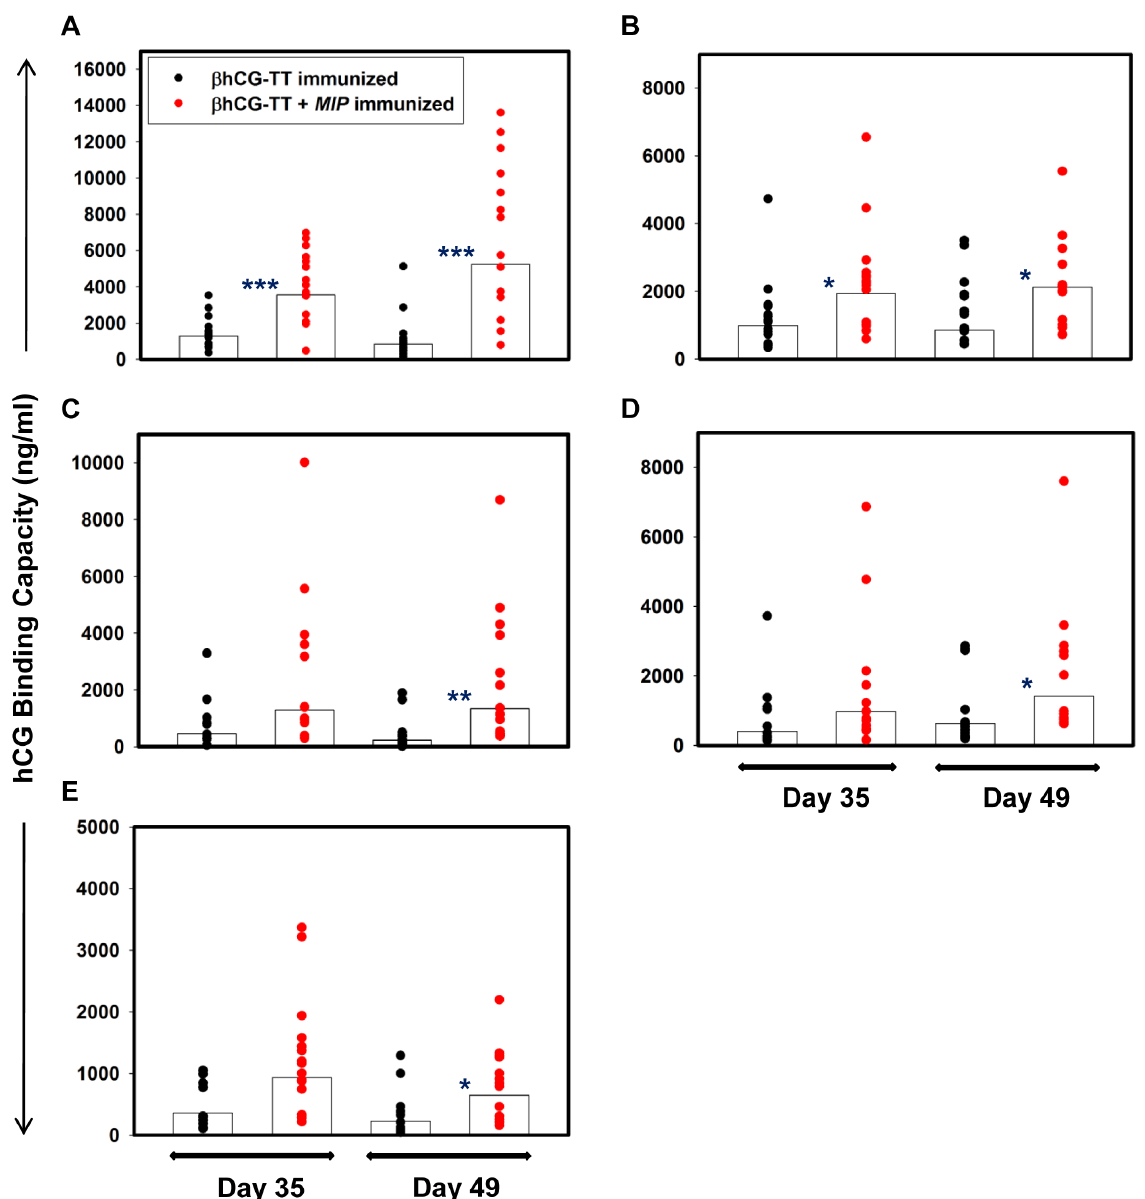
Figure 5. Immunogenecity studies. Immunogenicity of alum-adsorbed b hCG-TT and b hCG-TT + MIP in (A) BALB/c; (B) FVB/J; (C) C57BL/6; (D) CBA/ Cat and (E) C3H/HeJ mice. Each point represents hCG binding capacity of an individual animal and bars denote geometric means. ***p # 0.001, **p # 0.01, *p # 0.05 versus b hCG-TT immunized animals. n=16.